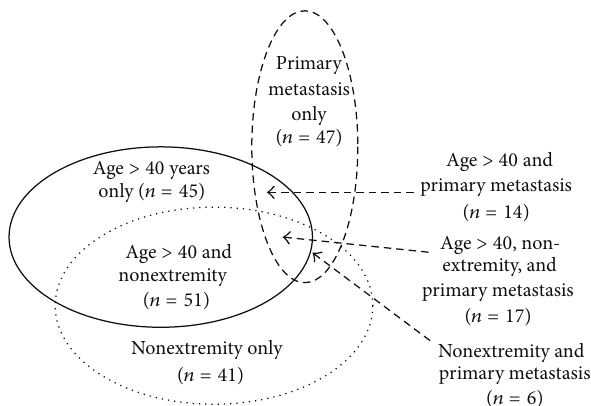
Figure 1: Nonclassical high-grade osteosarcoma (221 patients) with illustration of the overlaps between